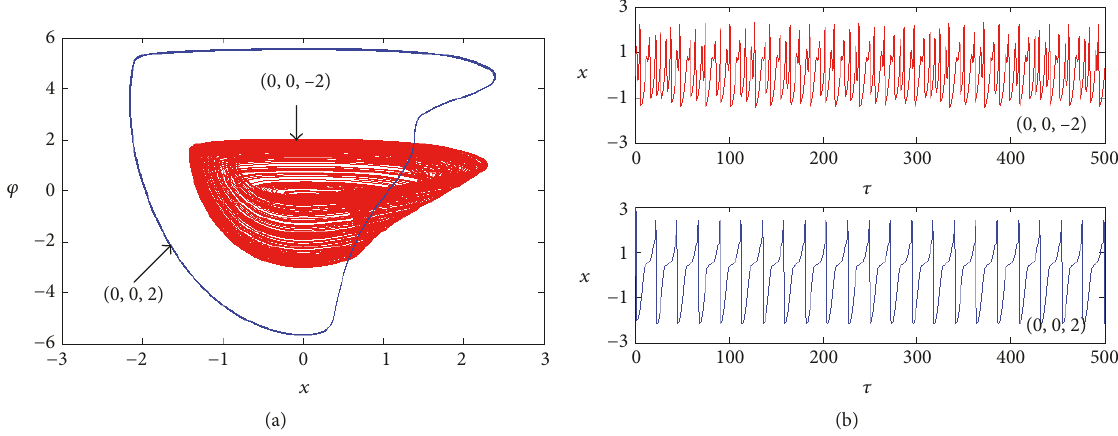
Figure 2: Hidden coexisting asymmetric attractors emerged from the initial values (0, 0, − 2) and (0, 0, 2). (a) Phase portraits in the 𝑥 - 𝜑 plane. (b) Time series of the variable 𝑥